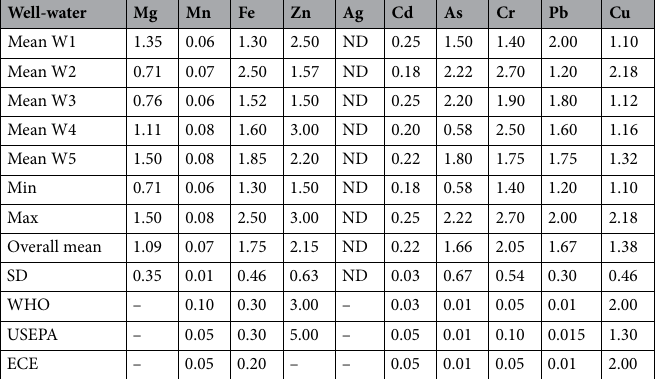
Table 6. Mean concentration of HMs in well-water samples obtained within the automobile spare part and recycling park in ppm. Detection Limit for Ag = 0.050 ppm. ND/NA not detectable/available, WHO World Health Organization 46 , USEPA United Stated Environmental Protection Agency 47 , ECE European Commission Environment 48 .